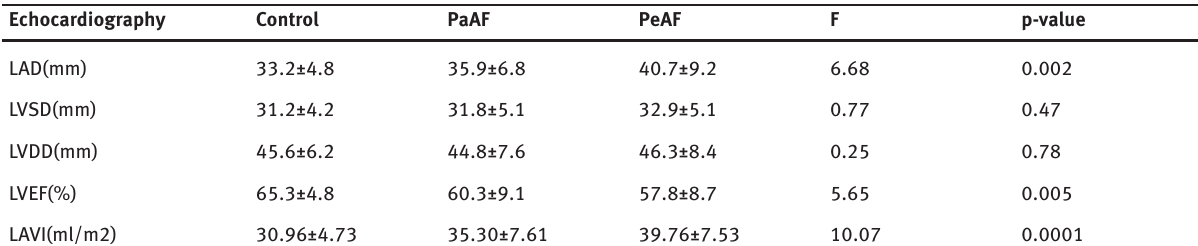
Table 2: The main measurement values of echocardiography for the 3 groups. Echocardiography